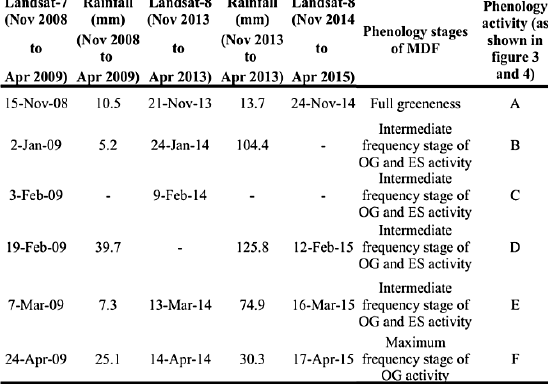
Table 1: Selected Landsat-7 and Landsat-8 datasets along with rainfall and phenology activity of corresponding months